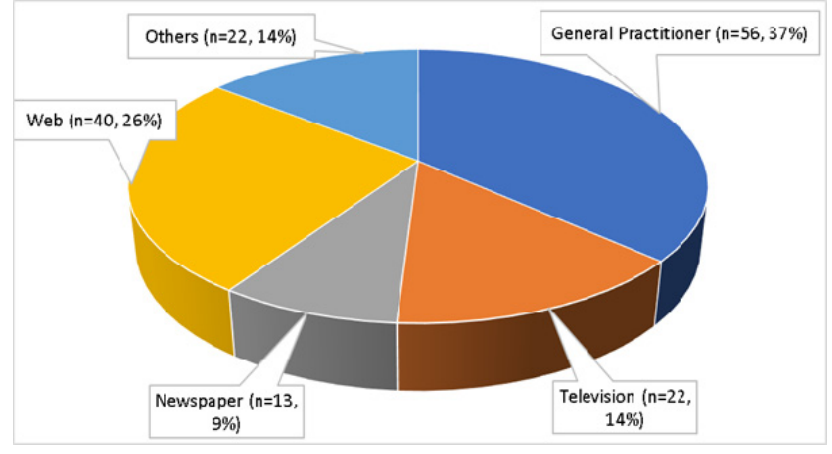
Figure 1. The sources of information on antibiotic resistance besides formal teaching ( n = 153).